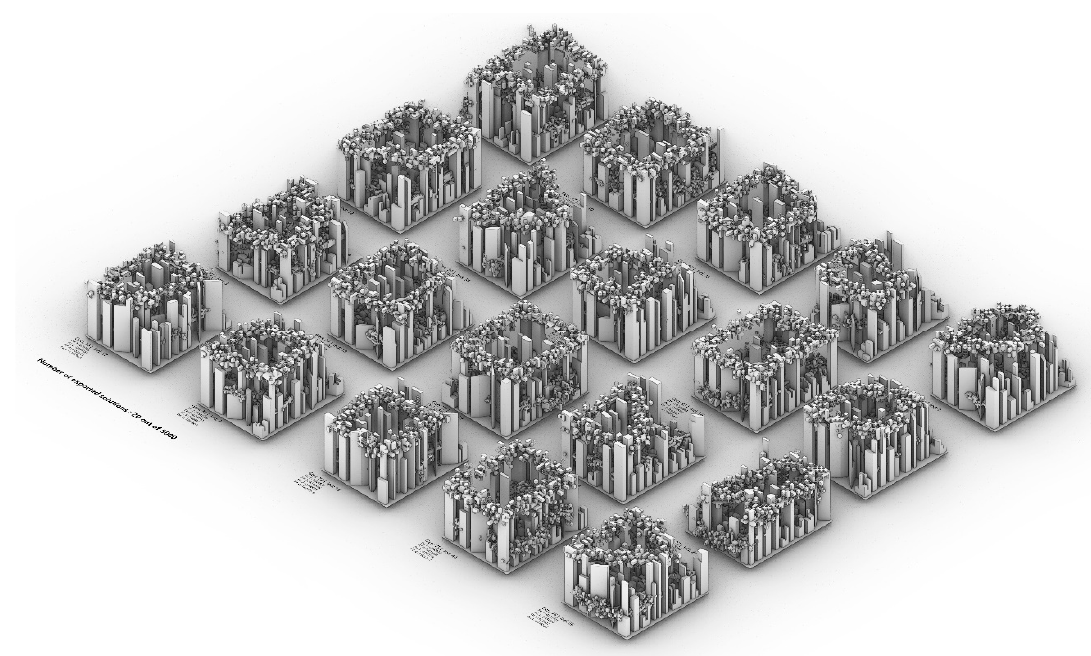
Figure 16. The phenotypes of the cluster centres extracted from the clustering algorithm.